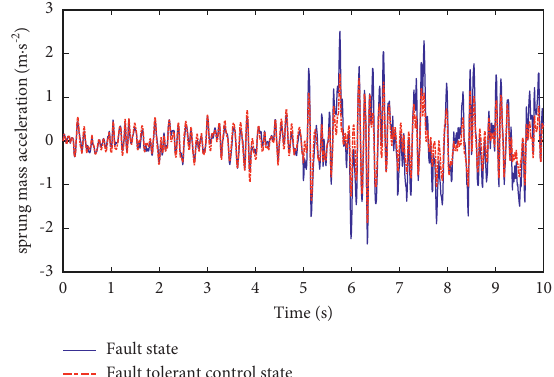
Figure 17: The time-domain response of the sprung mass accel- eration test.